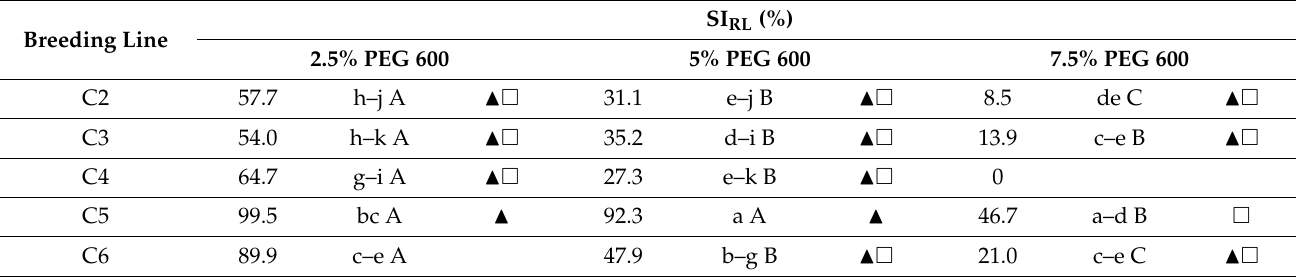
Table 8. Root length SI (SI RL ) values of potato genotypes under osmotic stress induced by PEG 600 added to the medium at levels of 2.5%, 5.0%, and